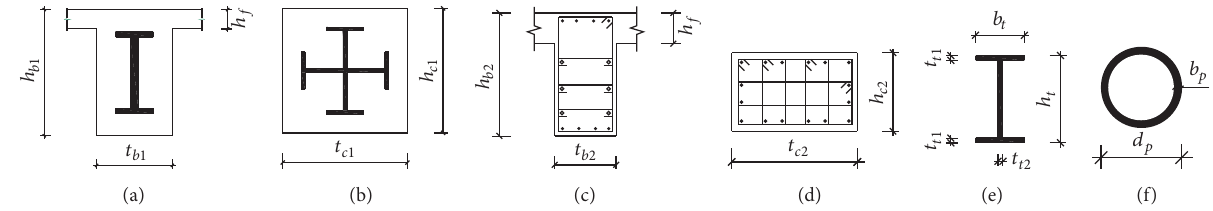
Figure 2: Sections of structural members used in the museum structure: (a) beam section of CFST; (b) column section of CFST; (c) beam section of RC; (d) column section of RC; (e) H-shaped steel member section; (f) sections of chords, webs, and suspenders used in steel truss.